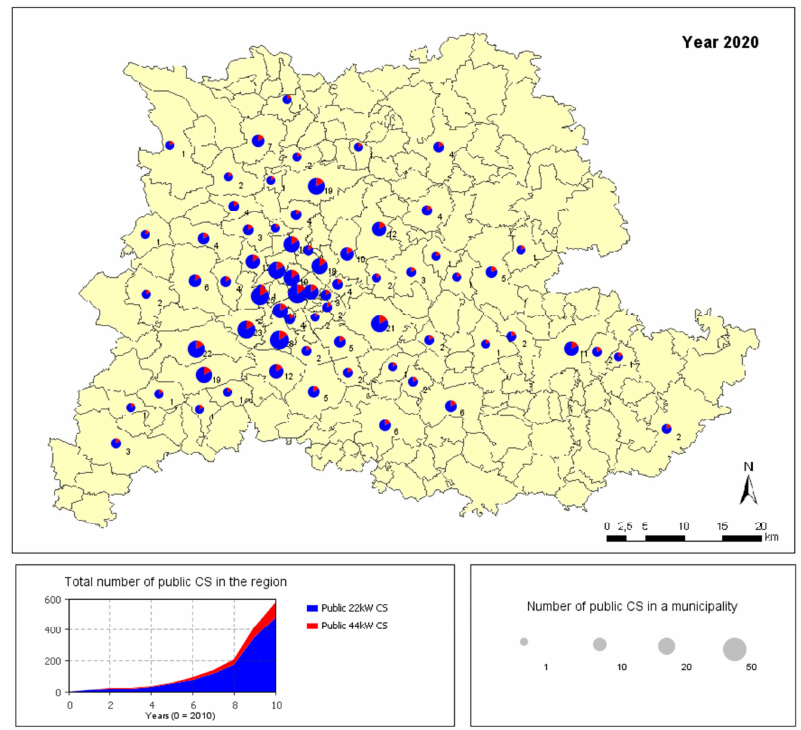
Figure 9. Development of public charging infrastructure until 2020 in the baseline